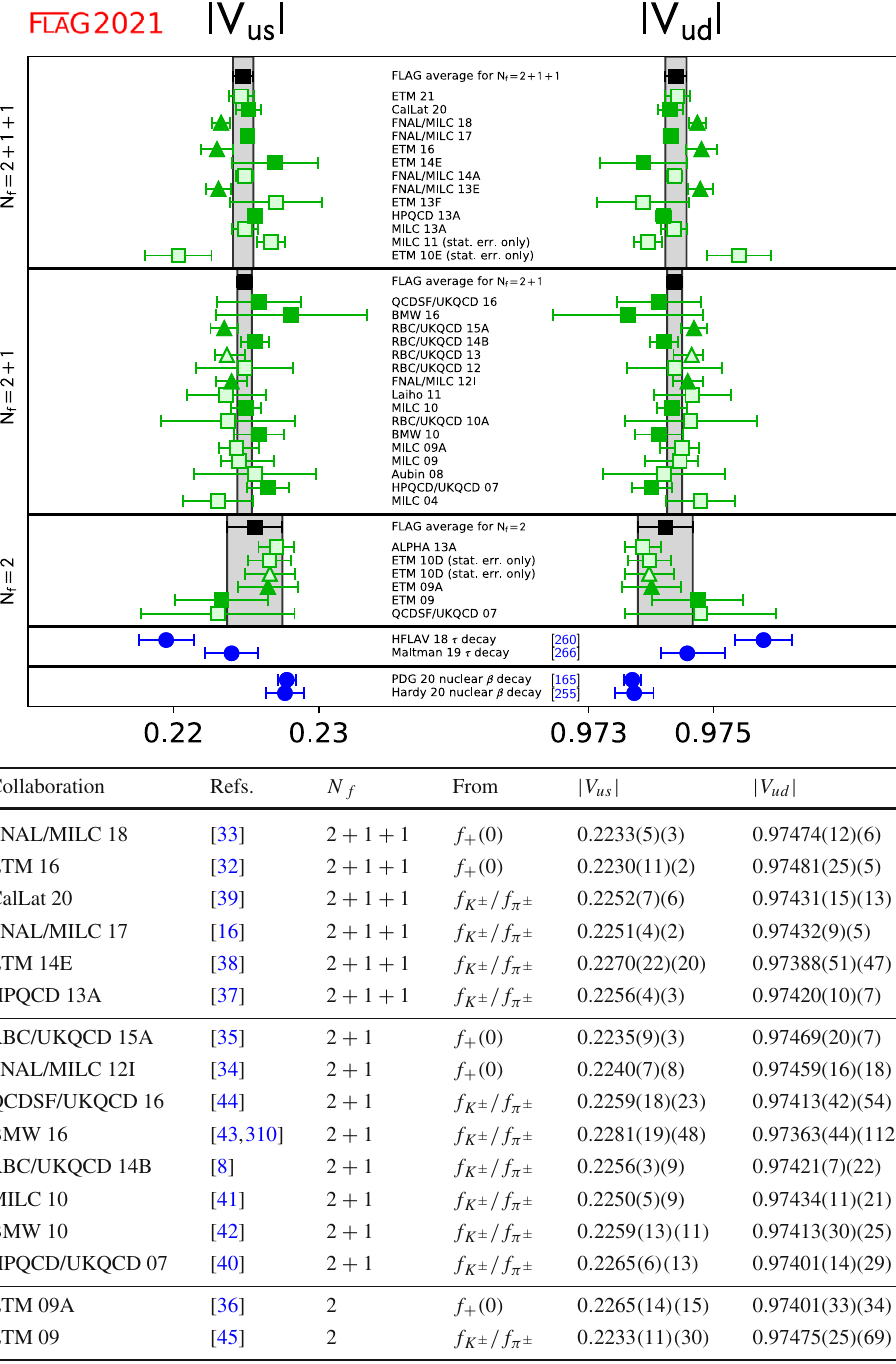
Fig. 12 Results for | V us | and | V | that follow from the lattice ud data for f + ( 0 ) (triangles) and f K ± / f π ± (squares), on the basis of the assumption that the CKM matrix is unitary. The black squares and the grey bands represent our averages, obtained by combining these two different ways of measuring | V | and | V | on a lattice. For us ud comparison, the figure also indicates the results obtained if the data on nuclear β decay and inclusive hadronic τ decay is analyzed within the Standard Model